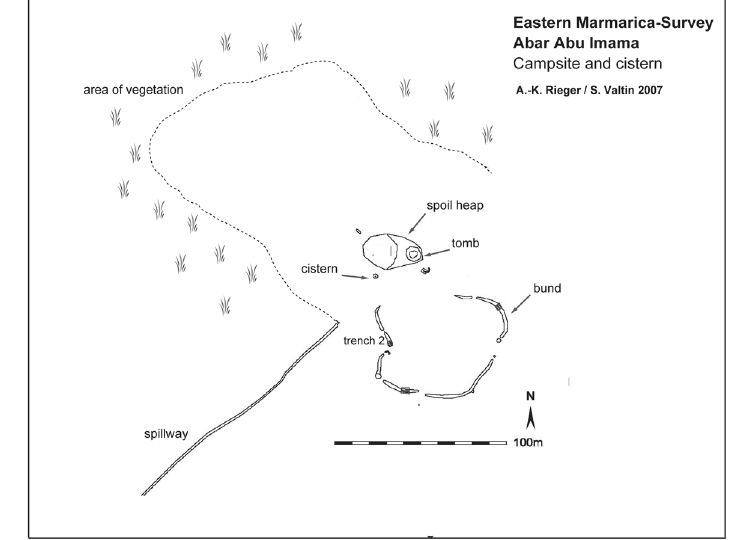
Fig. 6 . Map of the cistern site of Abar Abu Imama, showing an embanked area where a dense concentration of Roman pottery fragments points to human frequentation. (Anna-Katharina Rieger, Stephanie